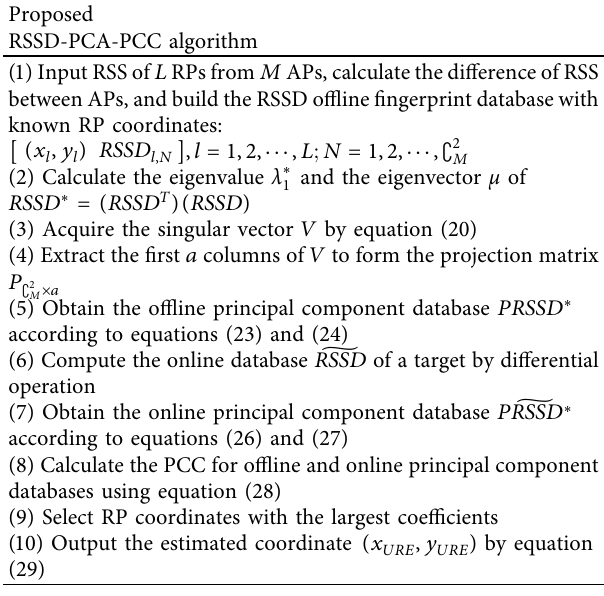
Table 4: Steps of the proposed RSSD-PCA-PCC algorithm.